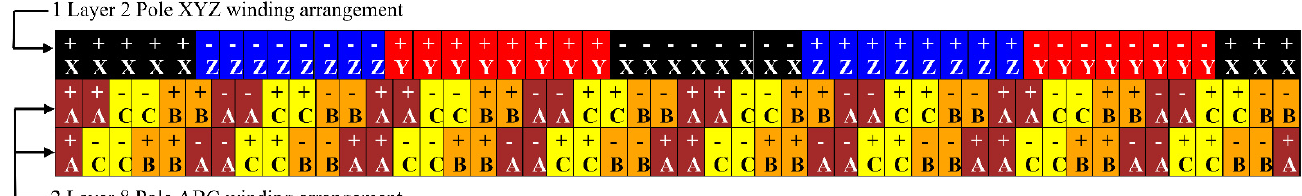
Figure 5. Proposed 3-layer ABC and XYZ winding configuration over 360-mechanical degrees.